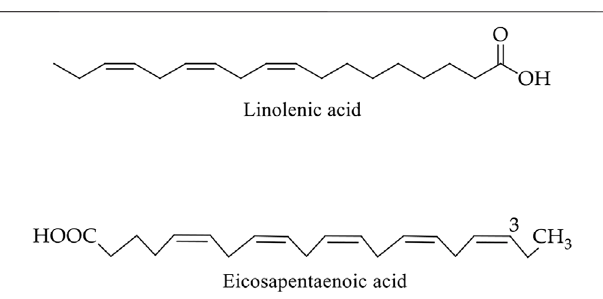
FIGURE 13 | Chemical structure of main bioactive compounds of fl axseed. α -Linolenic acid (18:3n-3) and eicosapentaenoic acid (20:5n-3) belong to the omega-3 fatty acids